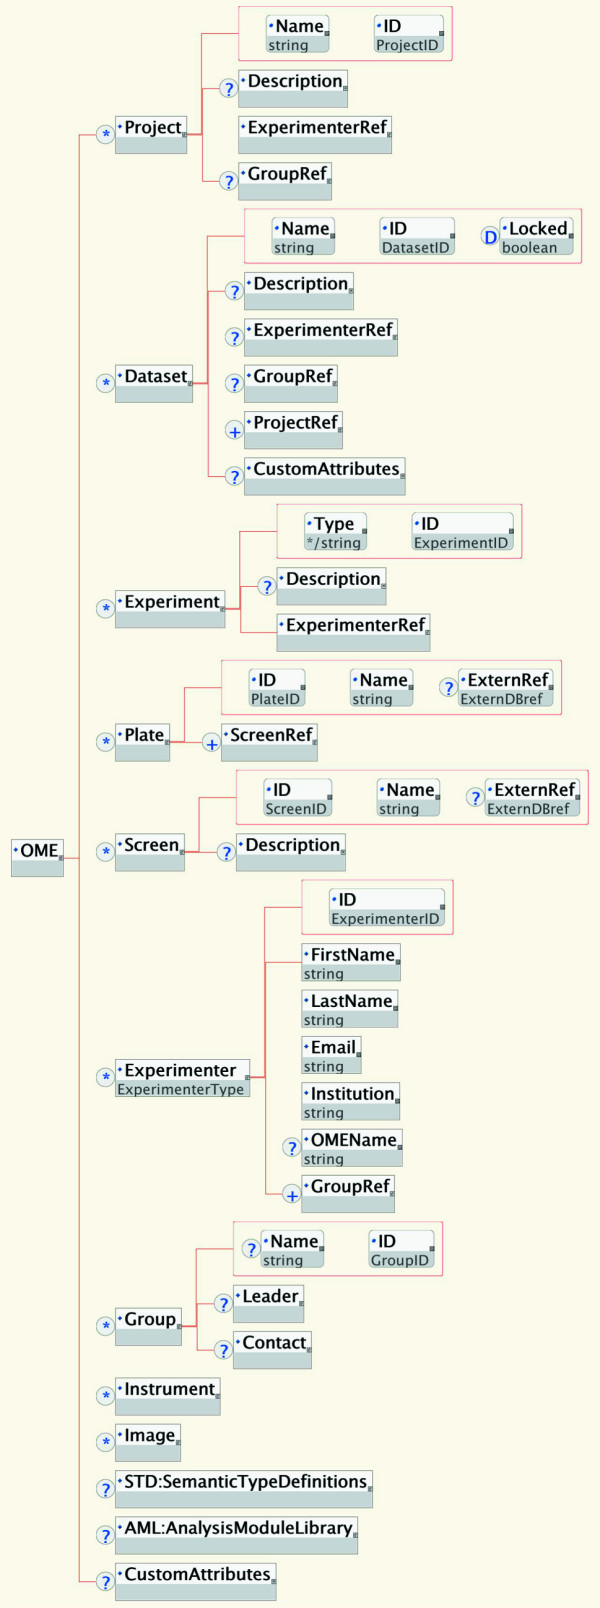
High-level view of the elements in the OME file schema. This figure (and Figures 3 and 4) should be read from left to right. A data type (for example, OME) is defined by a number of elements. In this case, OME is defined by Project, Dataset, Experiment, Image, and so on. Each of these elements can be defined by their own individual elements. The Image and Instrument elements are expanded in Figures 3 and 4. The full XML schema is available [24]. The full documentation for the schema is also available [25]. +, One or more elements of this type; ?, optional element or attribute; *, zero or more elements of this type; 1, choose one from a list of elements; D, the value of this element/attribute is constrained to one of several values, a range, or a text pattern (see the online documentation for more details [25]).